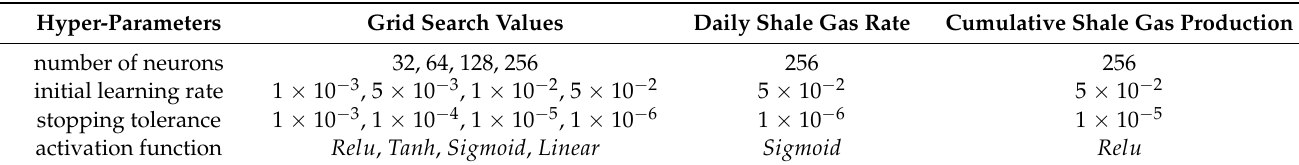
Table 3. The optimal grid values of hyper-parameters when using 500 training samples to train the ML